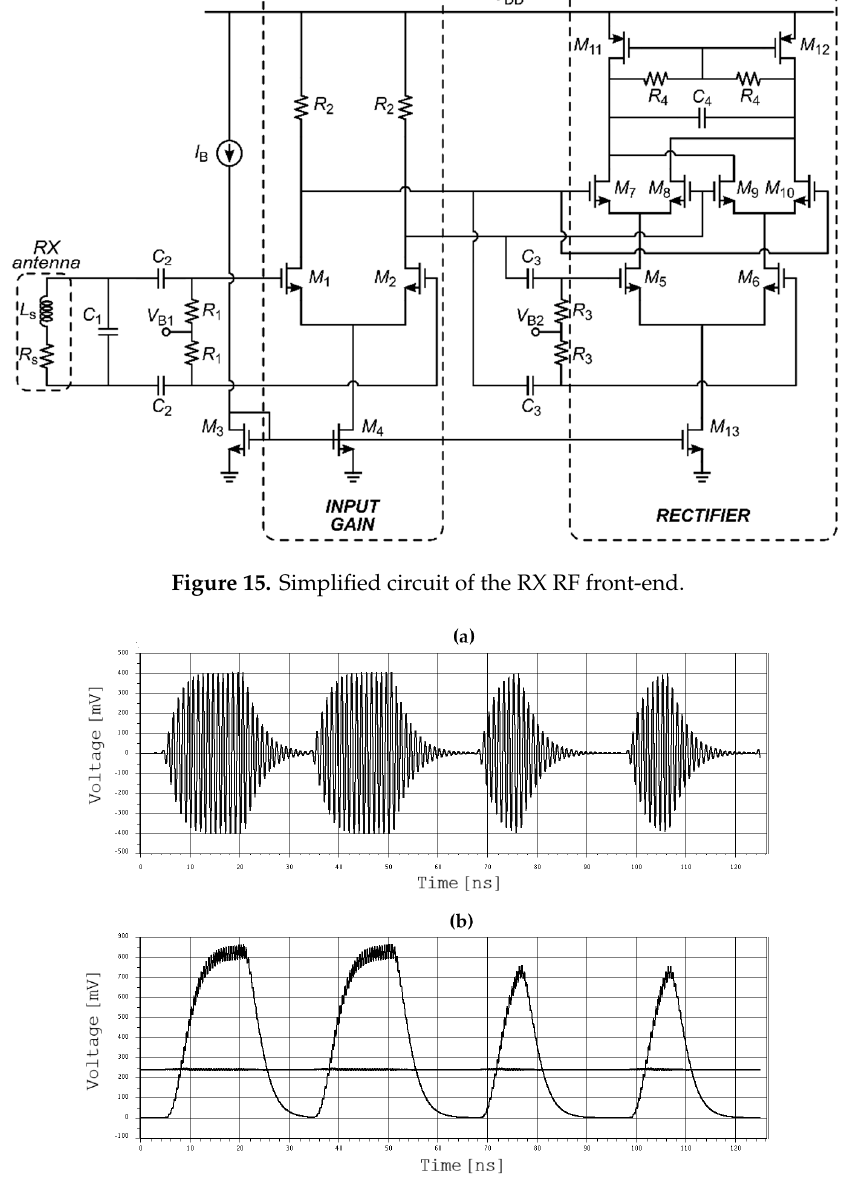
Figure 16. ( a ) Mixer input voltage; ( b ) RX envelope voltage and threshold voltage for PMW reconstruction ( f D = 33 MHz).